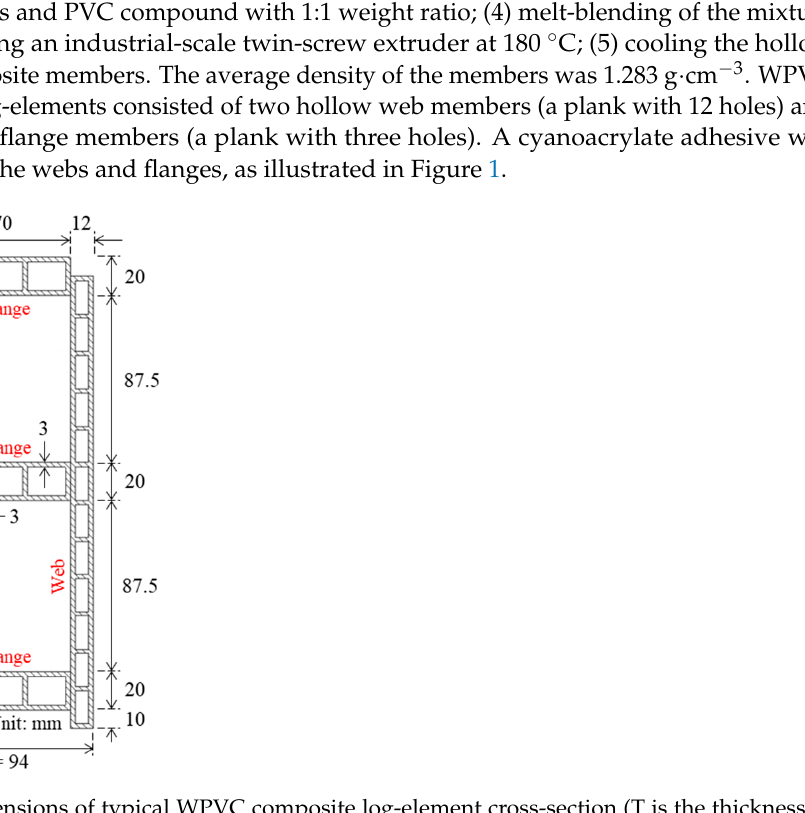
Figure 1. Dimensions of typical WPVC composite log-element cross-section (T is the thickness of log - element).